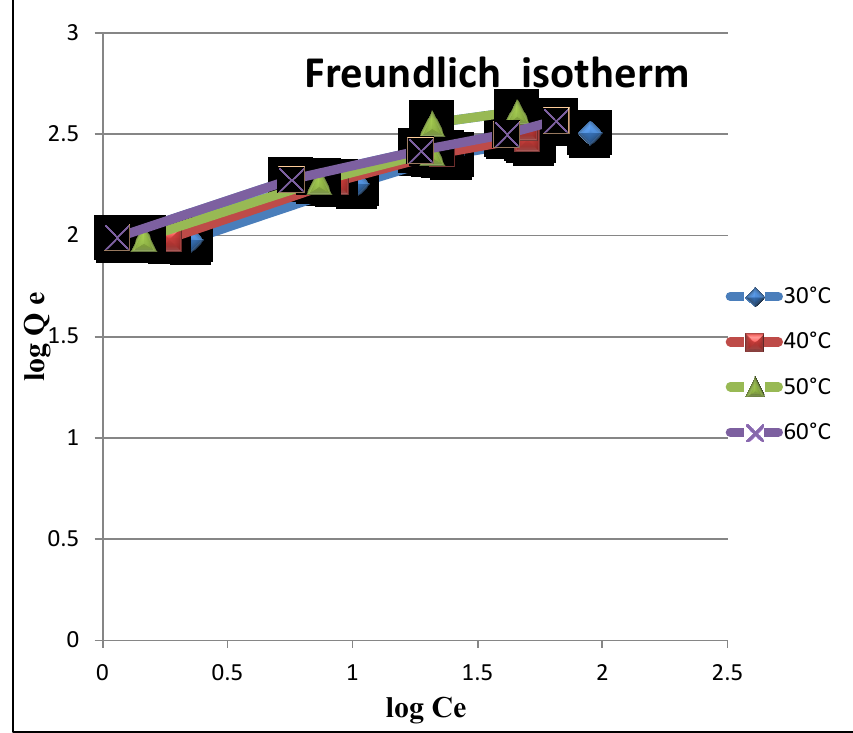
Figure 6. Freundlich Isotherm for the adsorption of malachite green onto